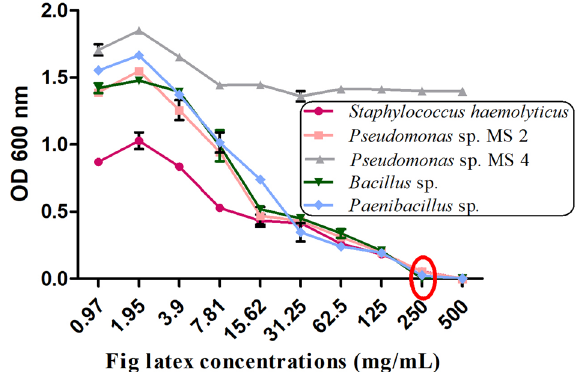
Figure 3. Minimum inhibition concentration (MIC) of fig latex for gram-positive and gram-negative bacteria. MIC reduction is presented as the decrease in the OD600 of the bacterial suspension treated with latex at various concentrations (0.97, 1.95, 3.9, 7.81, 15.62, 31.25, 62.5, 125, 250 and 500 μg/ml) against St. haemolyticus, Ps. MS2, Ps. MS4, Bacillus sp. and Paenibacillus sp. showing the MIC at 250 mg/ml with a red